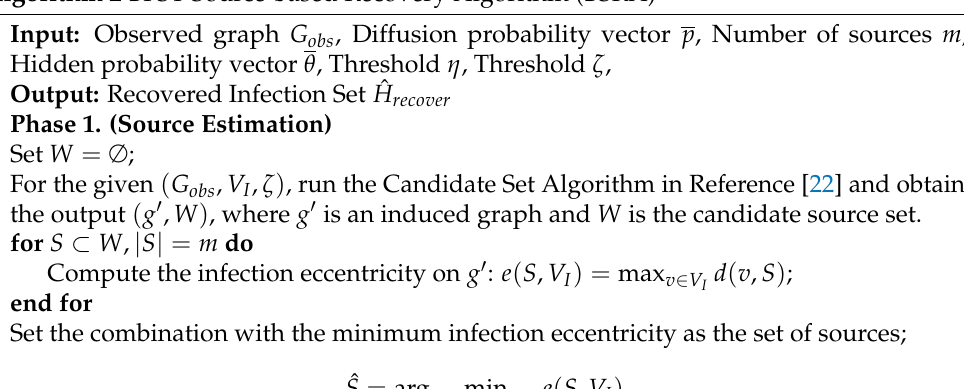
Algorithm 2 BFST Source-based Recovery Algorithm